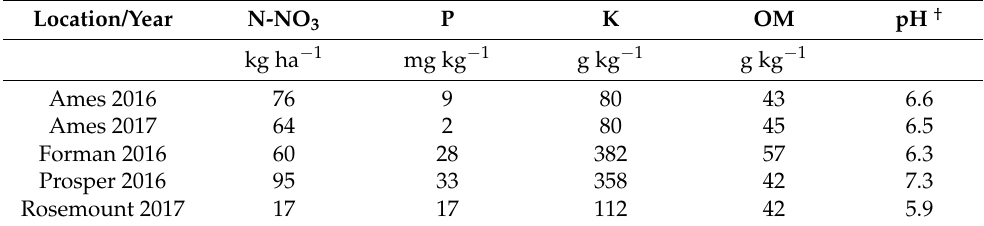
Table 4. Soil chemical analysis baseline for each location and